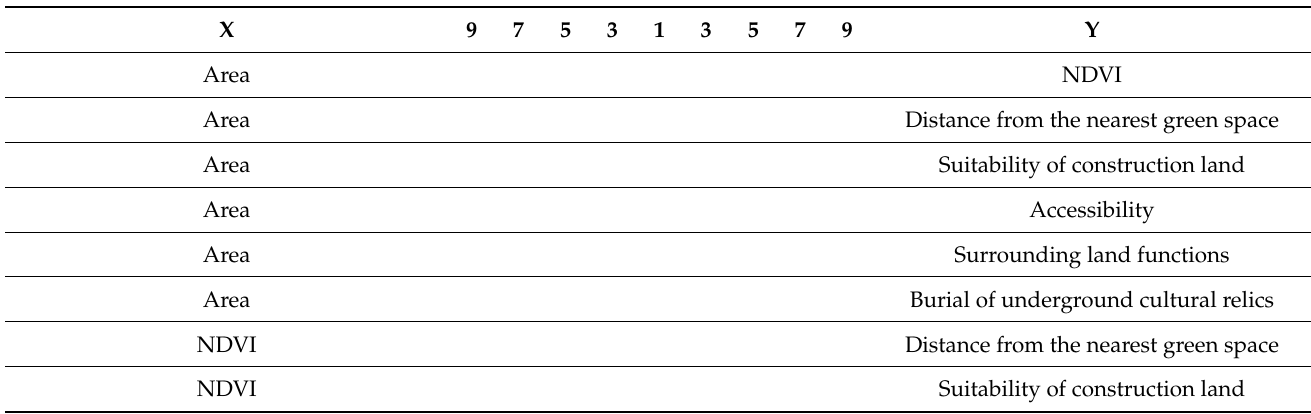
Table A4. Importance comparison of site suitability